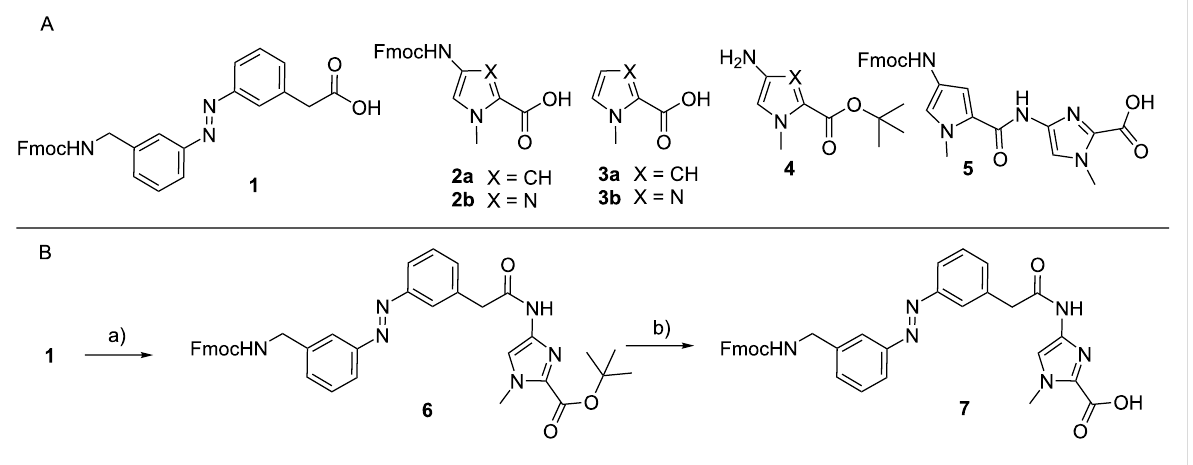
the Z- isomer, and it was noted that after one or two days, the percentage of Z- isomer was slightly reduced (after 2 d: 62% P1 ; 67% P2 ; after 1 d: 76% P3